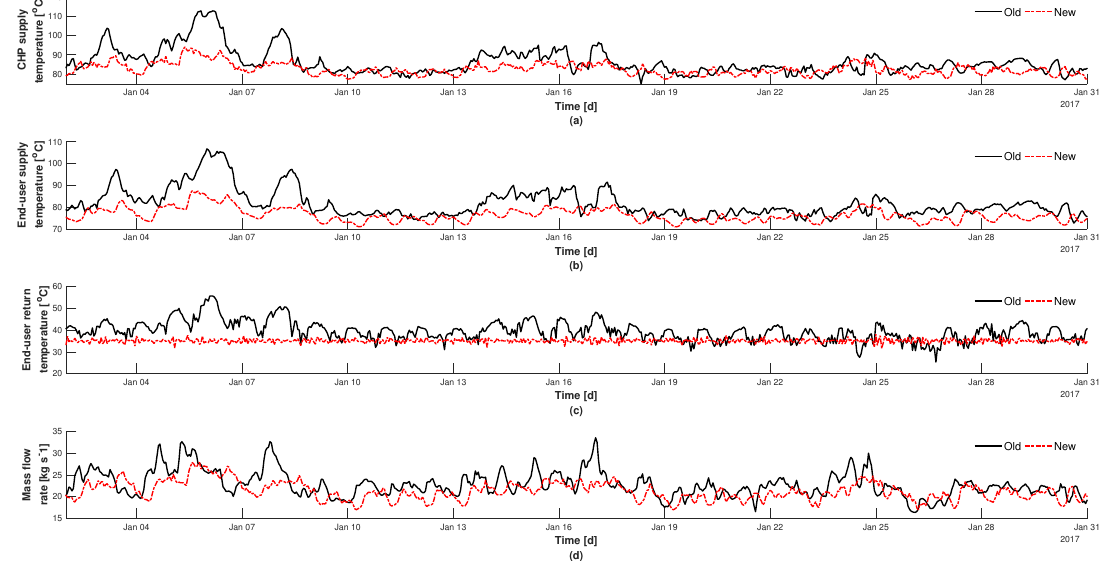
Figure 6. Implementation of FFMPC results and comparison between actual and controlled signals, Scenario 1. ( a ) supply temperature from CHP, ( b ) supply temperature to the end-user, ( c ) return temperature to CHP from the end-user, and ( d ) mass flow